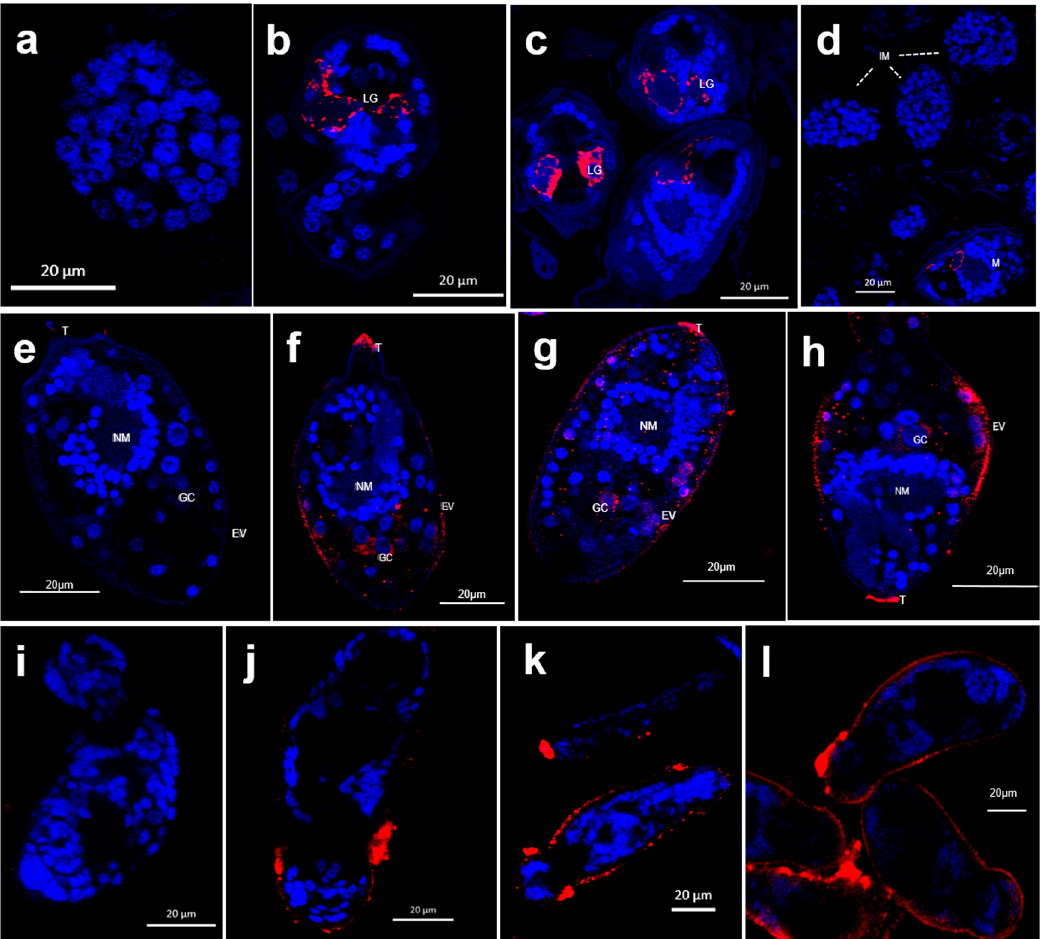
Figure 2. Immunofluorescence of Schistosoma japonicum insulin-like peptide (SjILP) in eggs, miracidia, and schistosomula following probing with mouse anti-SjILP antibody. Fixed mature eggs ( a – c ) and immature eggs (with one mature egg shown at the bottom of the panel) ( d ) isolated from livers of mice infected with S. japonicum, were incubated with: naïve control mouse serum ( a ) and mouse anti-rSjILP antiserum ( b – d ); fixed miracidia were exposed to naïve control mouse serum ( e ) and mouse anti-rSjILP antiserum ( f – h ); fixed schistosomula were exposed to naïve control mouse serum ( i ) and mouse anti-rSjILP antiserum ( j – l ). All samples were then incubated with Alexa fluor ® 647 goat anti-mouse IgG (red fluorescence). DAPI stained nuclei are blue. M-mature egg; IM-immature egg; LG-lateral gland cell; NM-neural mass; GC-germinal cell; EV-excretory vesicle; T-terebratorium.